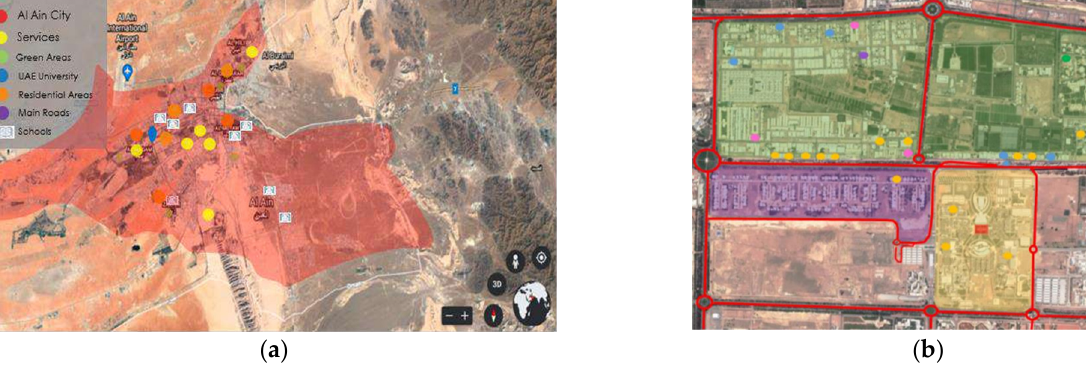
Figure 2. Site analysis ( a ) city level, ( b ) neighborhood level.